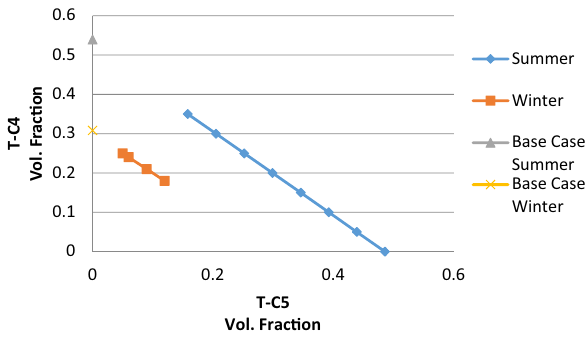
Fig. 29 Effect of adding a mixture of 2,2DMP and i-C5 on LPG T-C4 content